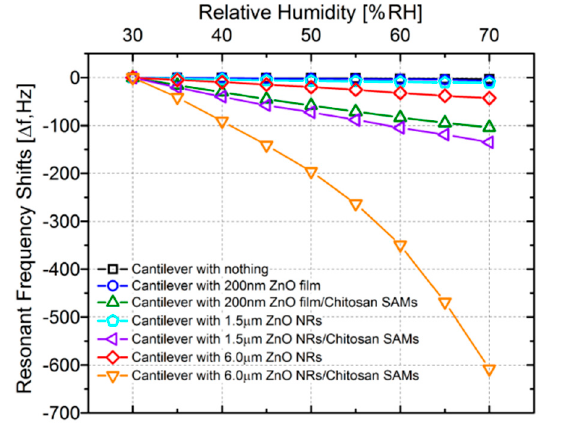
Figure 5. RF shifts of blank microcantilevers and microcantilevers with sputtered/annealed ZnO film (200 nm), ZnO film (200 nm)/chitosan, ZnO NRs (1.5 µm), ZnO NRs (1.5 µm)/chitosan, ZnO NRs (6 µm), ZnO NRs (6 µm)/chitosan under different RH levels ranging from 30% RH to 70% RH at 25